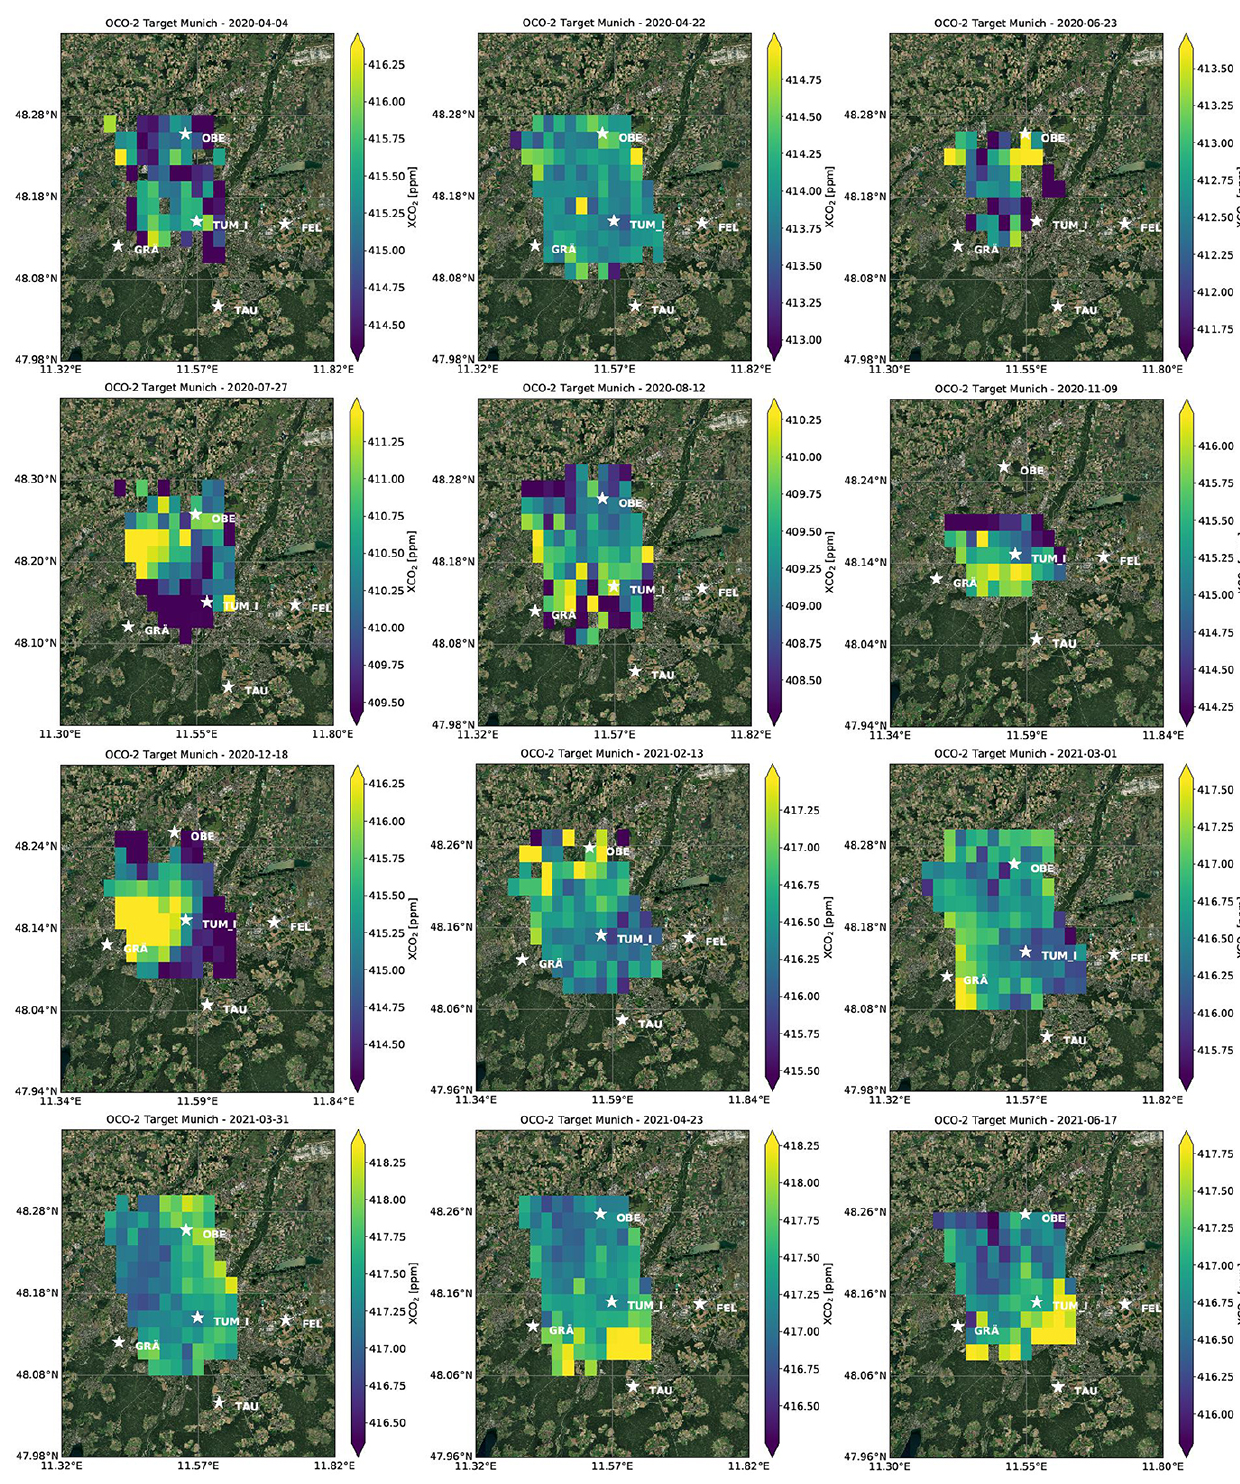
Figure 3. Daily X CO maps of OCO-2 target observations in Munich. MUCCnet spectrometer locations are highlighted on the map. The 2 OCO-2 target-mode data are binned into 0.02 ◦ × 0.02 ◦ latitude–longitude grid cells. Map source: Esri, Maxar, Earthstar Geographics, and the GIS User